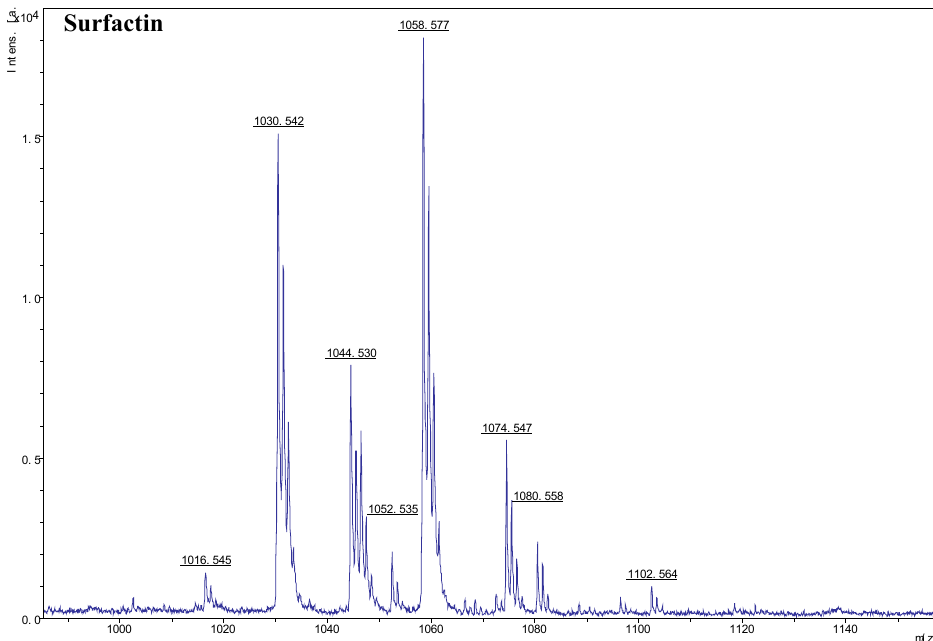
Figure 4. MALDI-TOF mass spectra from Bacillus halotolerans JK-25 with the m/z range 1000–1140. m / z represent their corresponding lipopeptides.